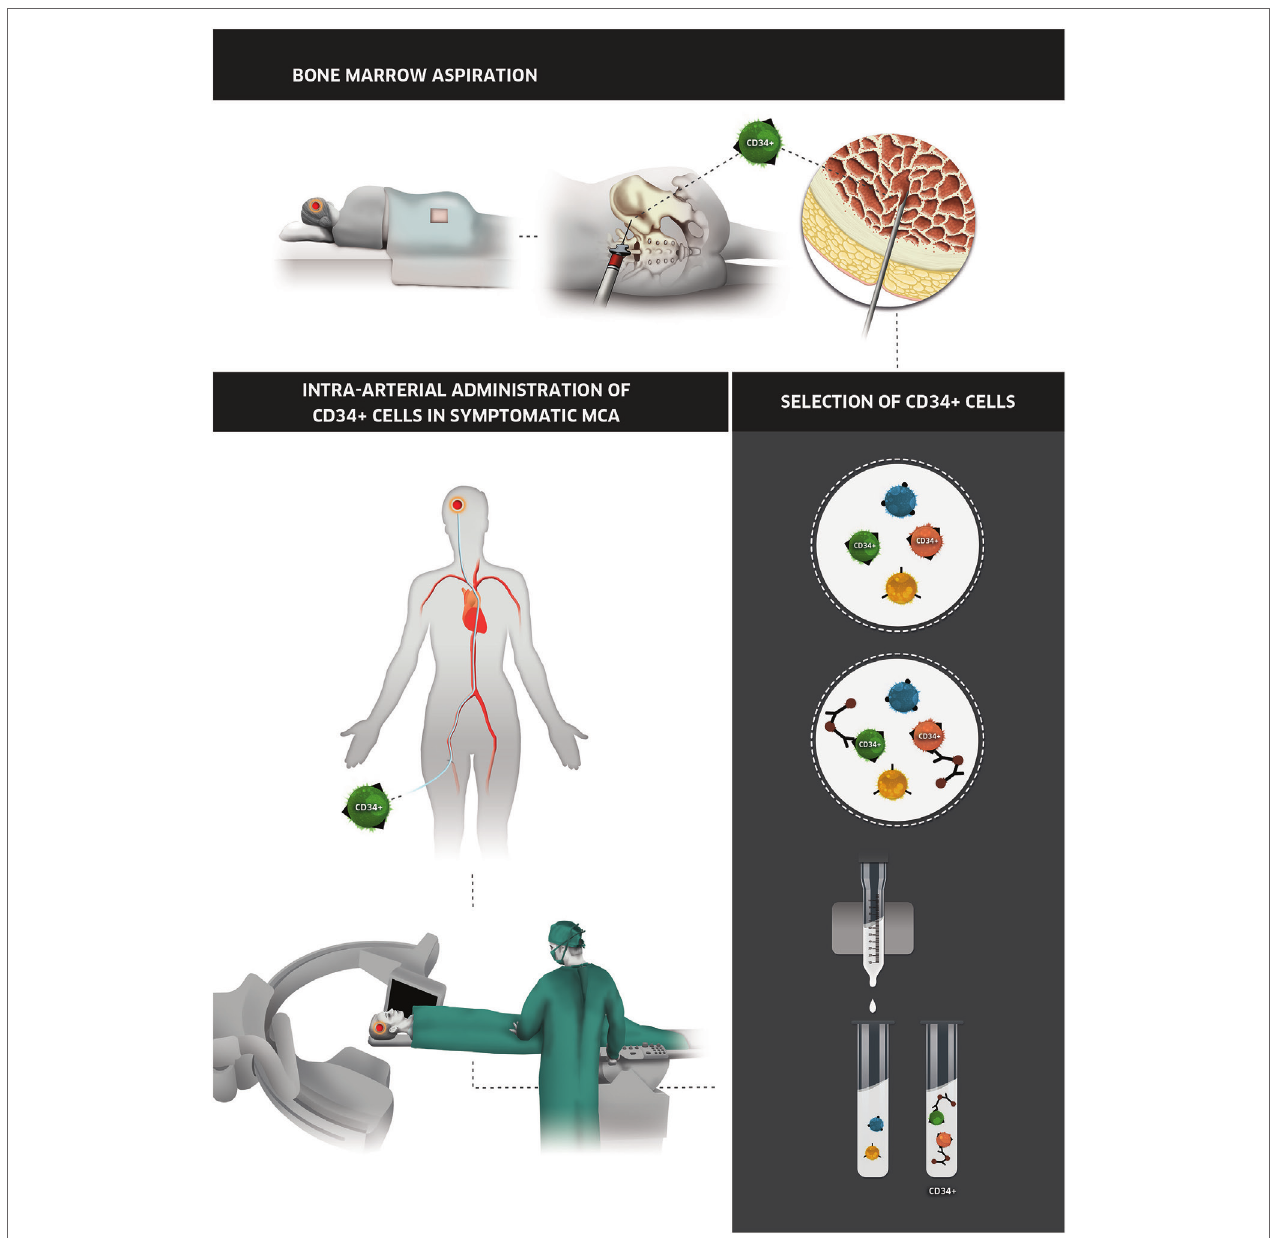
FigurE 2 | Illustrative representation of autotransplant of CD34 + cells. In the top of the image, bone marrow aspiration by hematologist is represented. The second step (bottom right) is the isolation of CD34 + cells, followed by the intra-arterial administration of the CD34 + in the symptomatic MCA (bottom left). Abbreviation: MCA, middle cerebral